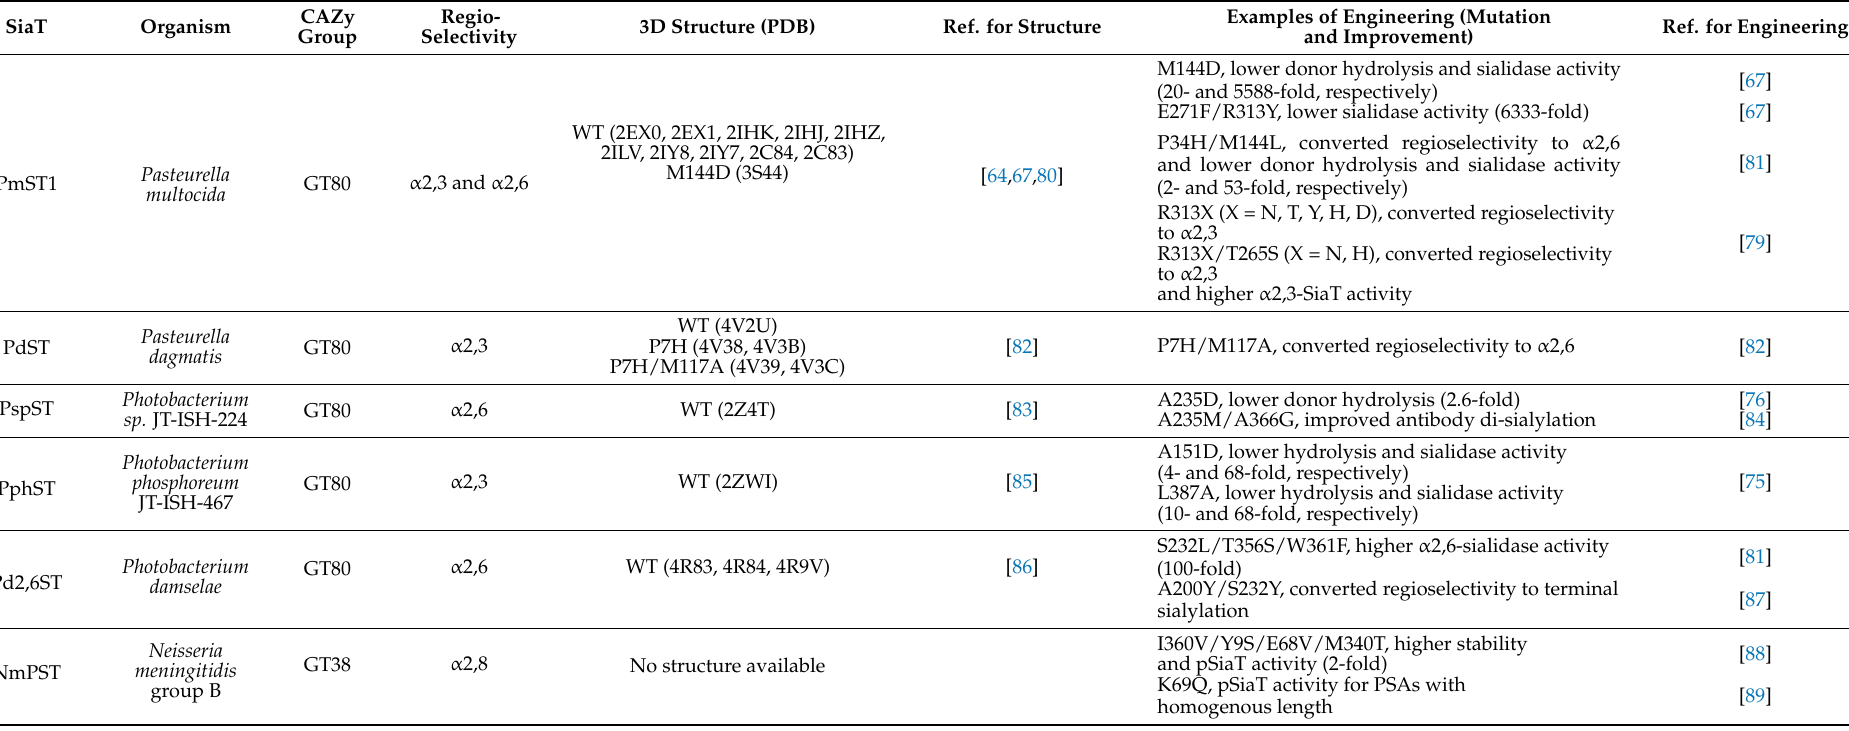
Table 1. List of bSiaTs discussed in this review, including their 3D structures and examples of